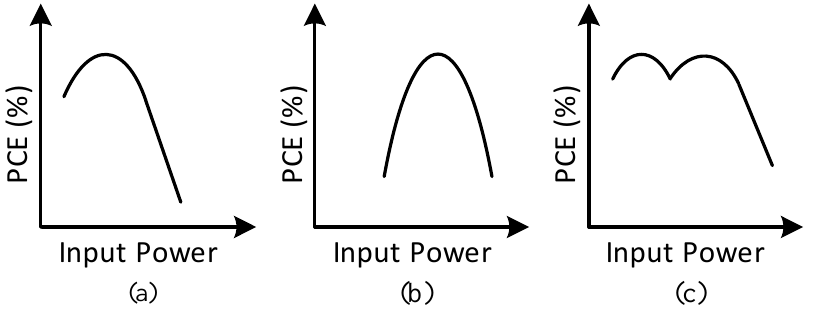
Figure 2. Conventional rectifier’s efficiencies: ( a ) at low-power; ( b ) at high-power; and ( c ) proposed reconfigurable rectifier’s efficiency.